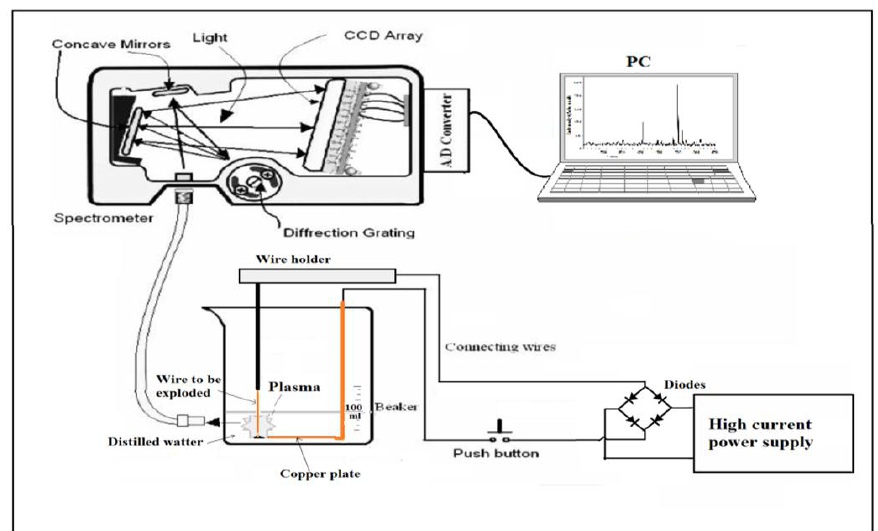
Fig. 1: Schematic diagram for the basic circuit used for exploding the copper wires and produce